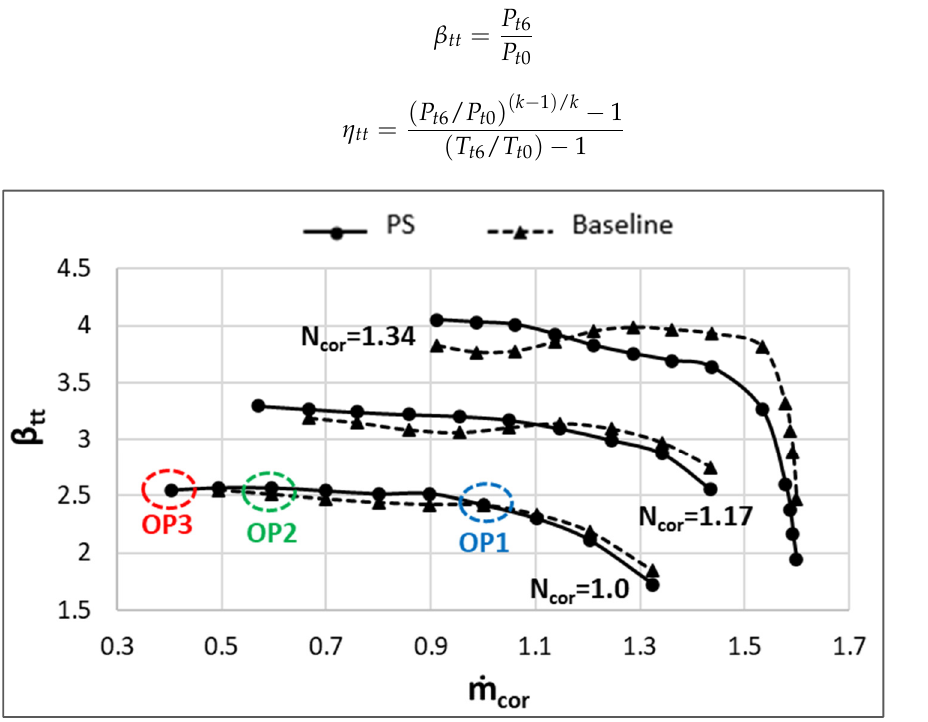
Figure 6. Comparison of the characteristic curve of the pressure ratio between the ported shroud case and the baseline case, at different rotational speeds.